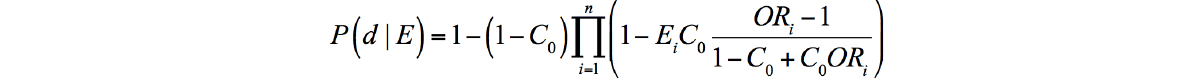
Figure 10. Probability to fall from risk factor odds